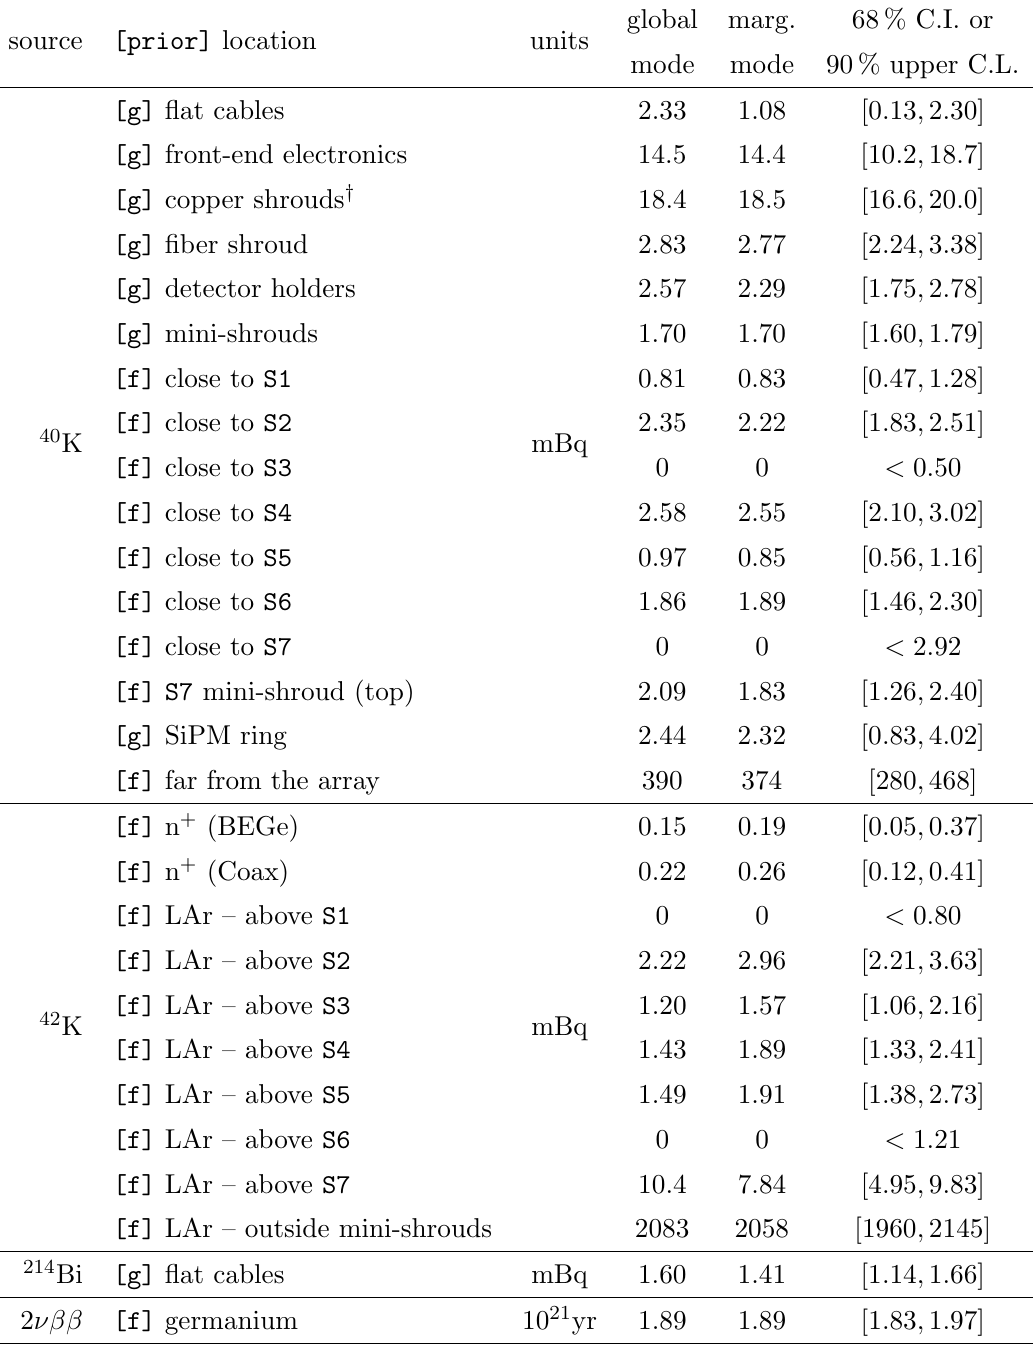
Table 6. Summary of the (cid:12)t parameters estimated with the potassium source tracking analysis (extended model). The type of prior distribution is indicated with [f] : (cid:13)at, [g] : Gaussian.